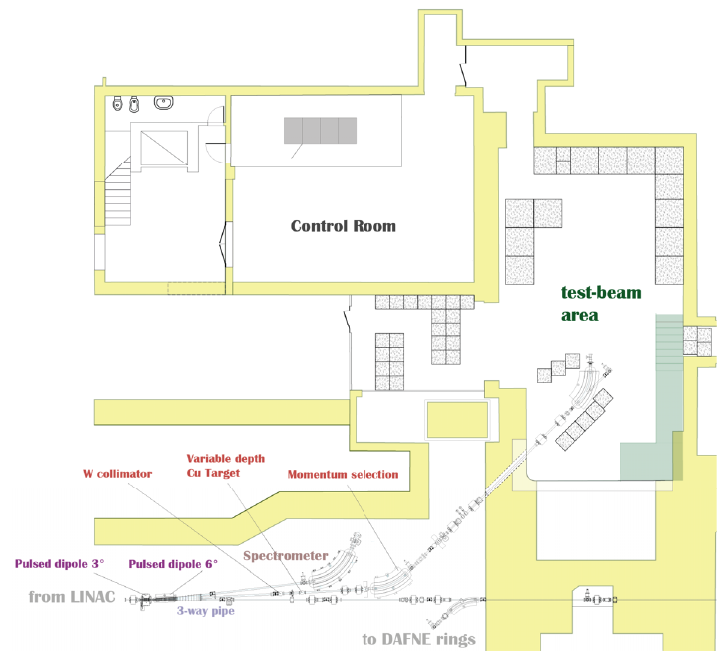
Figure 1. General layout of the Beam-Test Facility (BTF) of the Frascati DA Φ NE accelerator